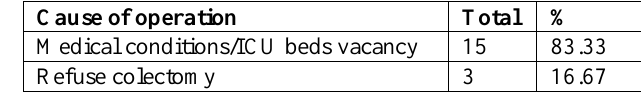
Table 1: Causes of doing defunctioning loop ileostomy Cause of